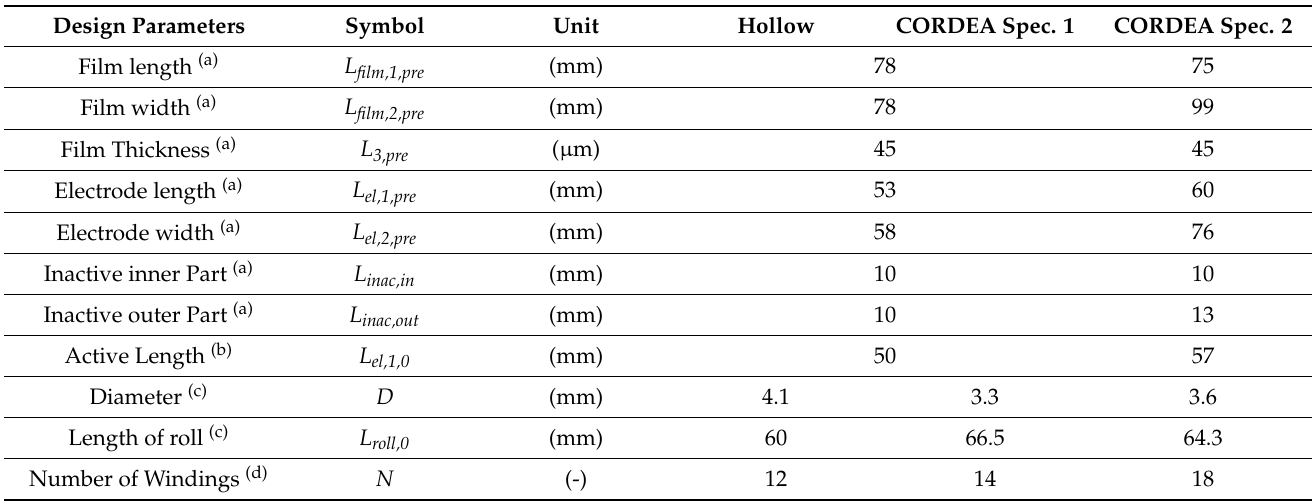
Table 2. Dimensions of the films and electrodes.